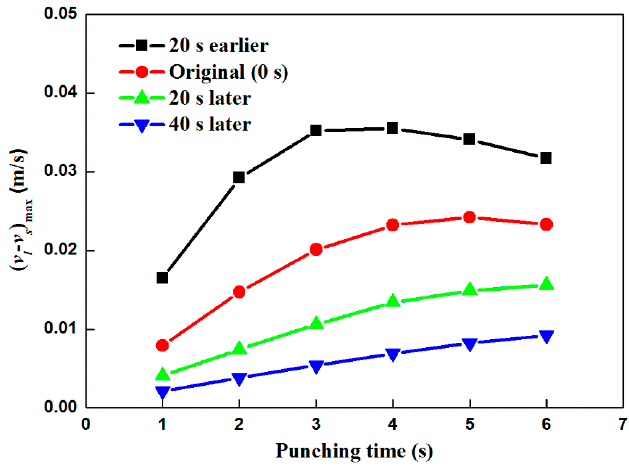
Figure 12. The evolution of the maximum relative velocity using different punching start times.